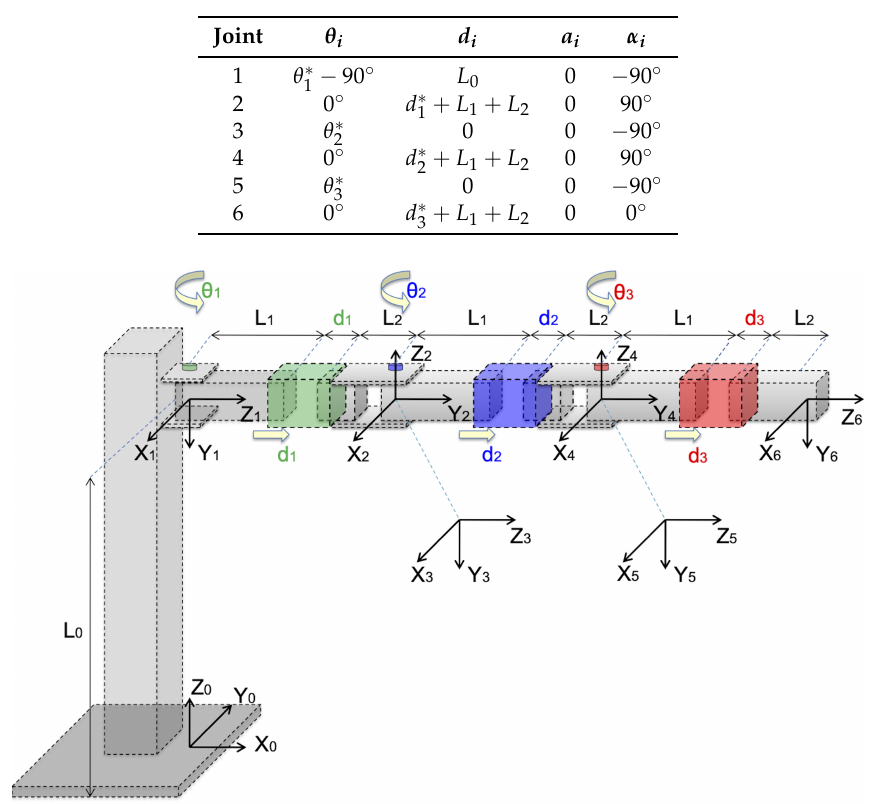
Table 1. Joint parameters of the 6-DoF redundant planar manipulator robot.